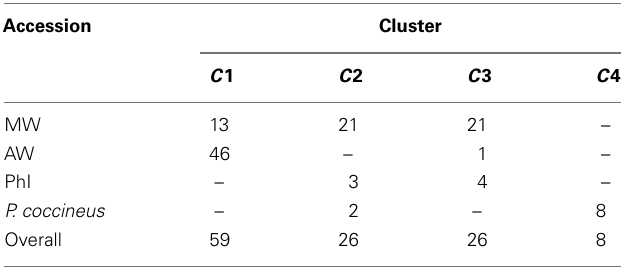
Table 2 | Distribution of the accessions into the four cpSSR clusters ( C 1, C 2, C 3, C 4) identified by the BAPS analysis.